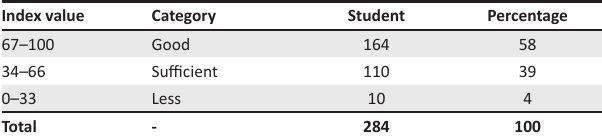
TABLE 5: Categories of disaster knowledge. TABLE 4: Main research questions for